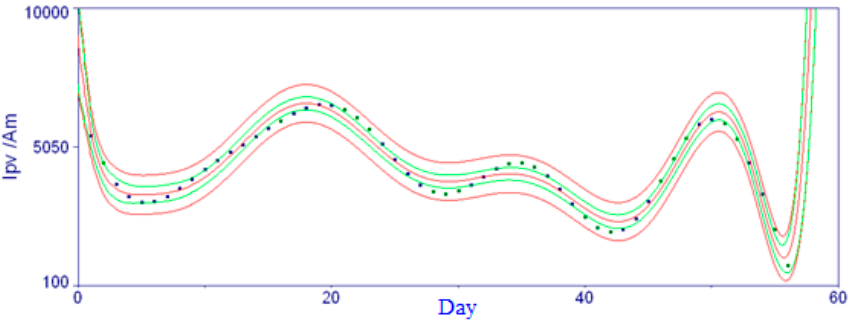
Figure 15. The result of the forecasting proposed model illustrated in the Equation (13).